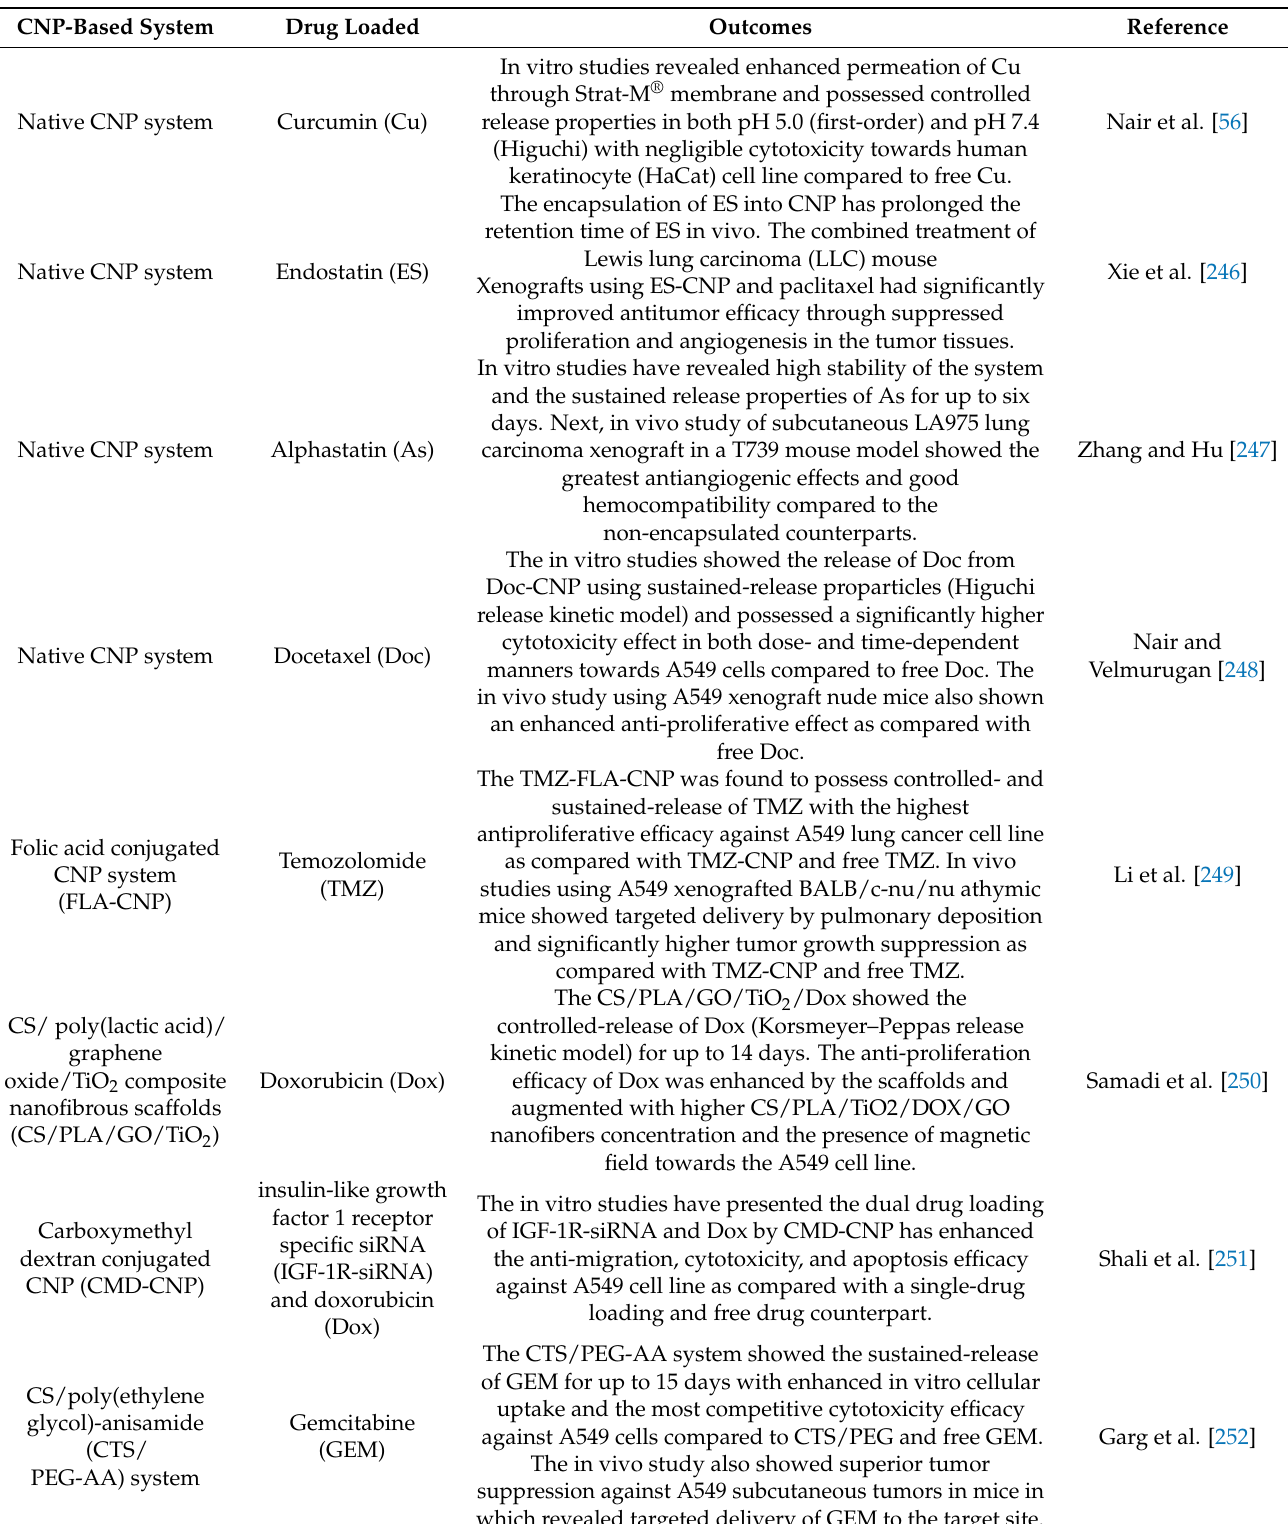
Table 2. The outcome of drug-loaded CNP-based system for enhanced therapeutic efficacy/prolonged retention